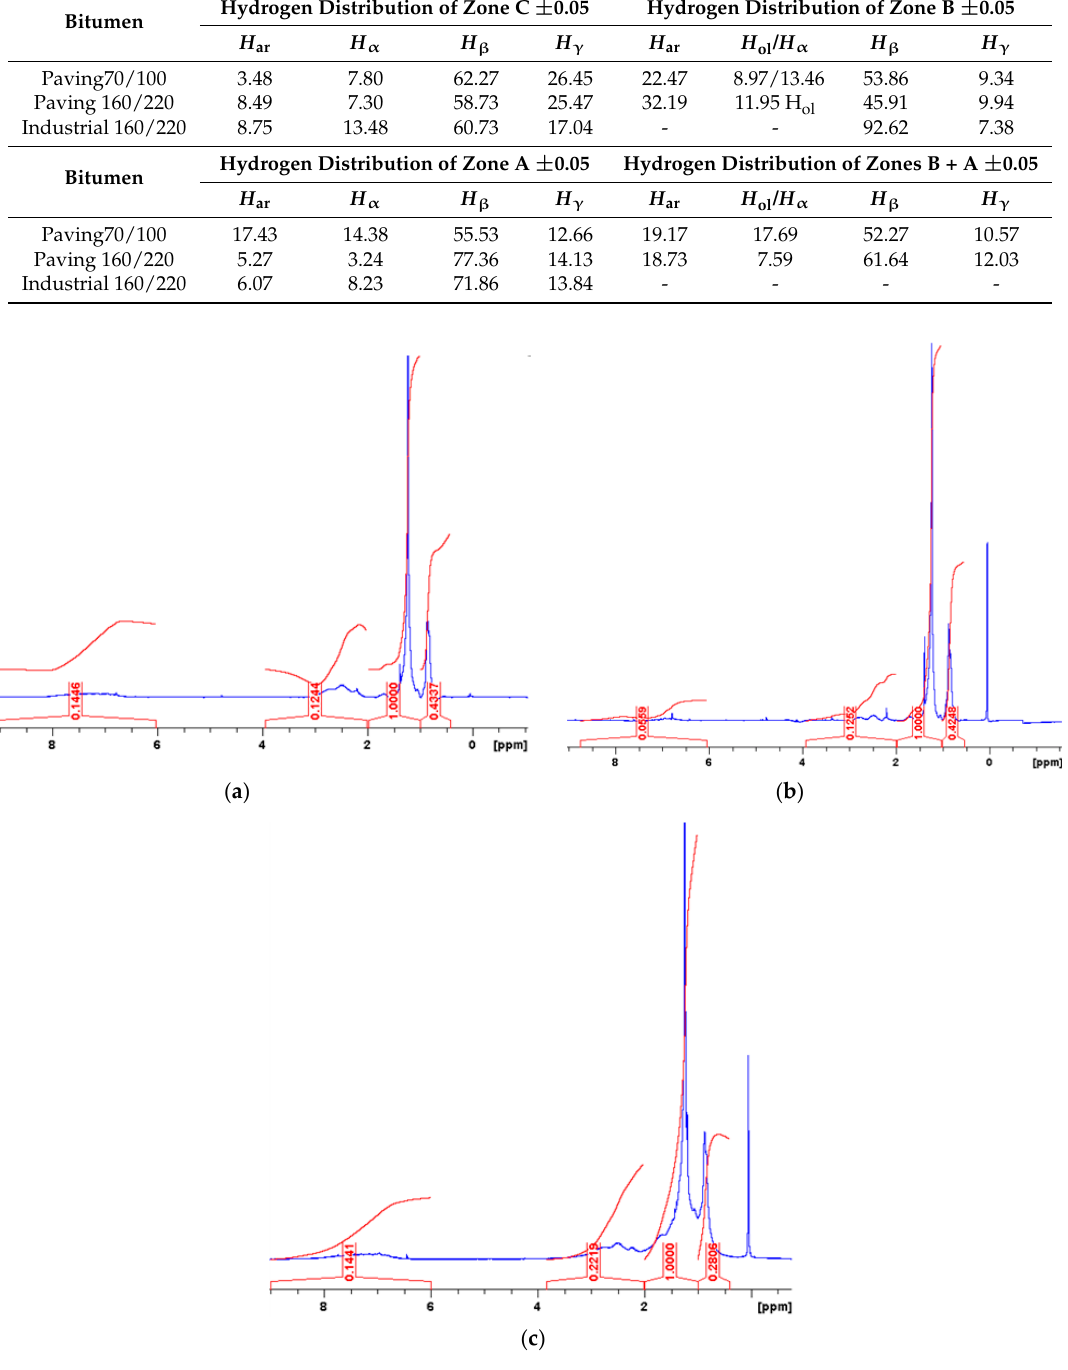
Figure 7. The 1 H-NMR spectra of zone C obtained through a preparative TLC for the three bitumens: ( a ) paving 160/220; ( b ) paving 70/100; and ( c ) industrial 160/220.